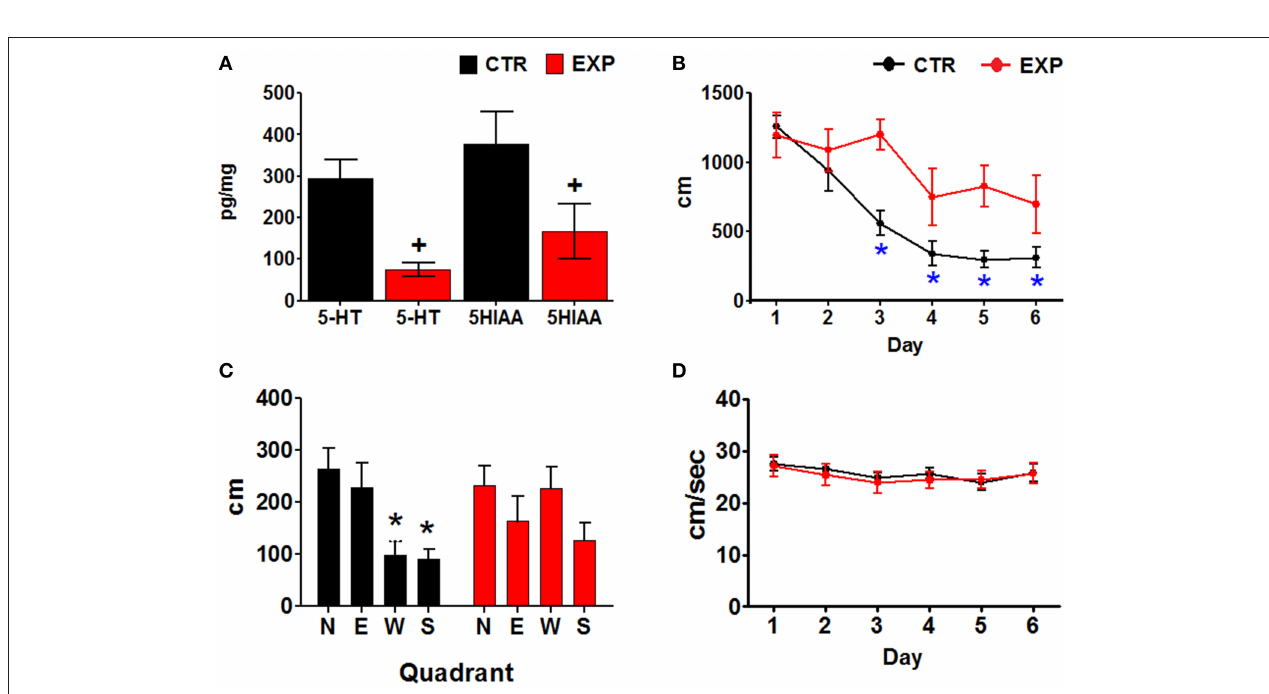
FIGURE 2 | (A) Serotonin and 5-HIAA concentrations. Mean ± SEM, p < 0.05 . (B) Distances traveled by the two groups of animals, through the training days. Mean ± SEM. *Day 1 vs. subsequent days, p < 0.001 . (C) Distance traveled in each quadrant during the probe test of the two groups of rats. The escape platform was placed in the north quadrant during the training. North (N), South (S), East (E), and West (W) quadrants. Mean ± SEM. *N quadrant vs. all other quadrants; + , group CTR vs. EXP, p < 0.05 . (D) Swimming velocities displayed by the two groups of animals through the training days. Mean ±